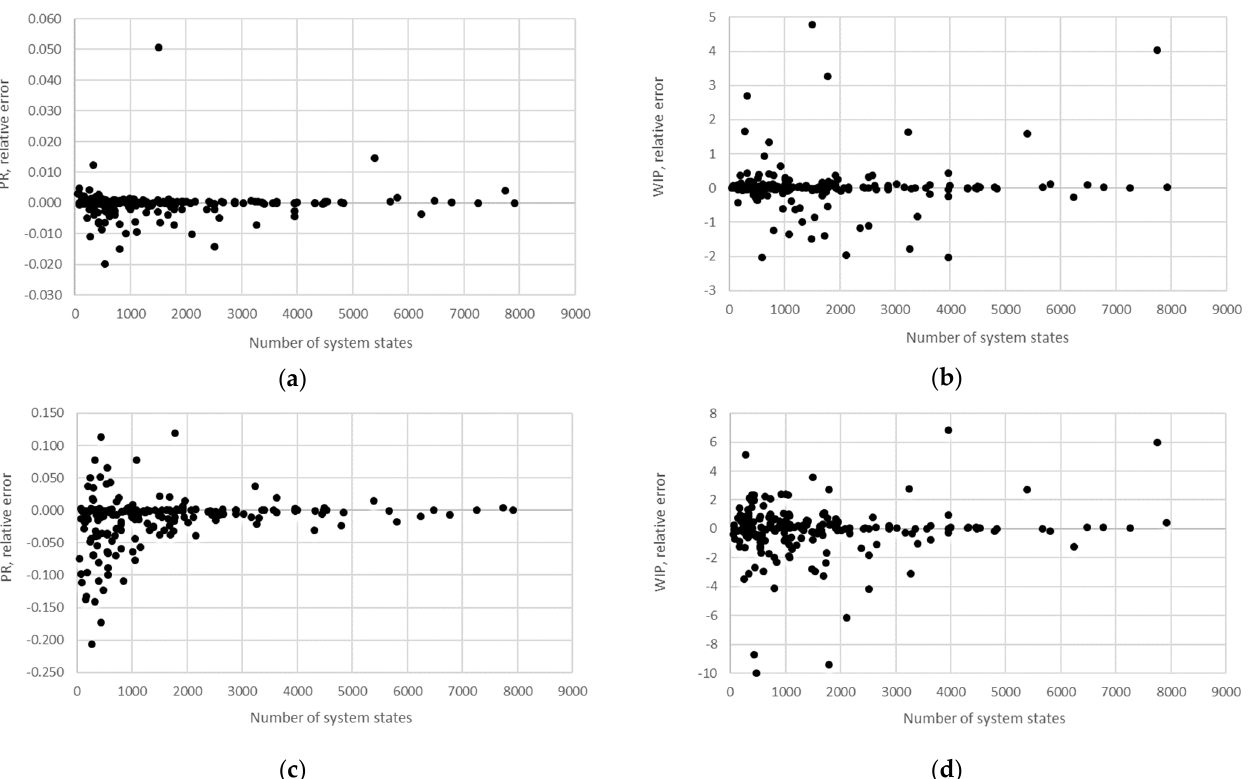
Figure 14. M = 5, relative error obtained using the ( a , b ) AGG procedure and ( c , d ) FSM.